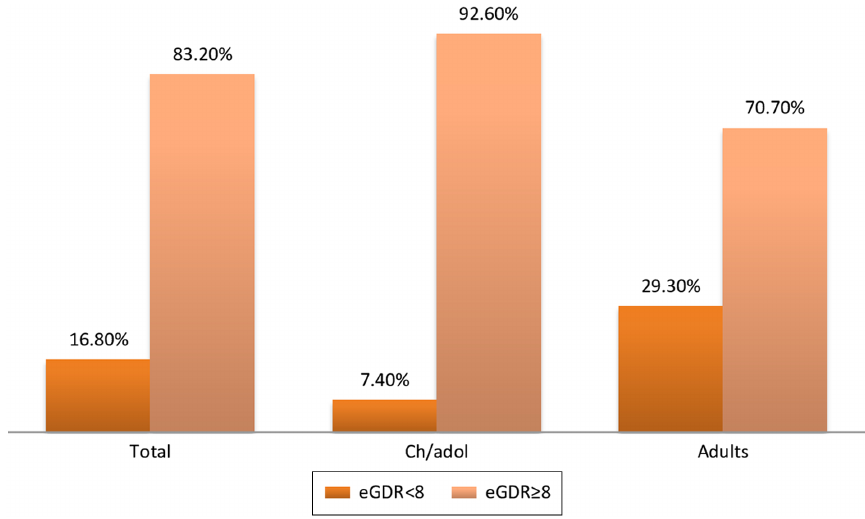
Figure 1. Prevalence of IR in children/adolescent and adults. IR, insulin resistance.